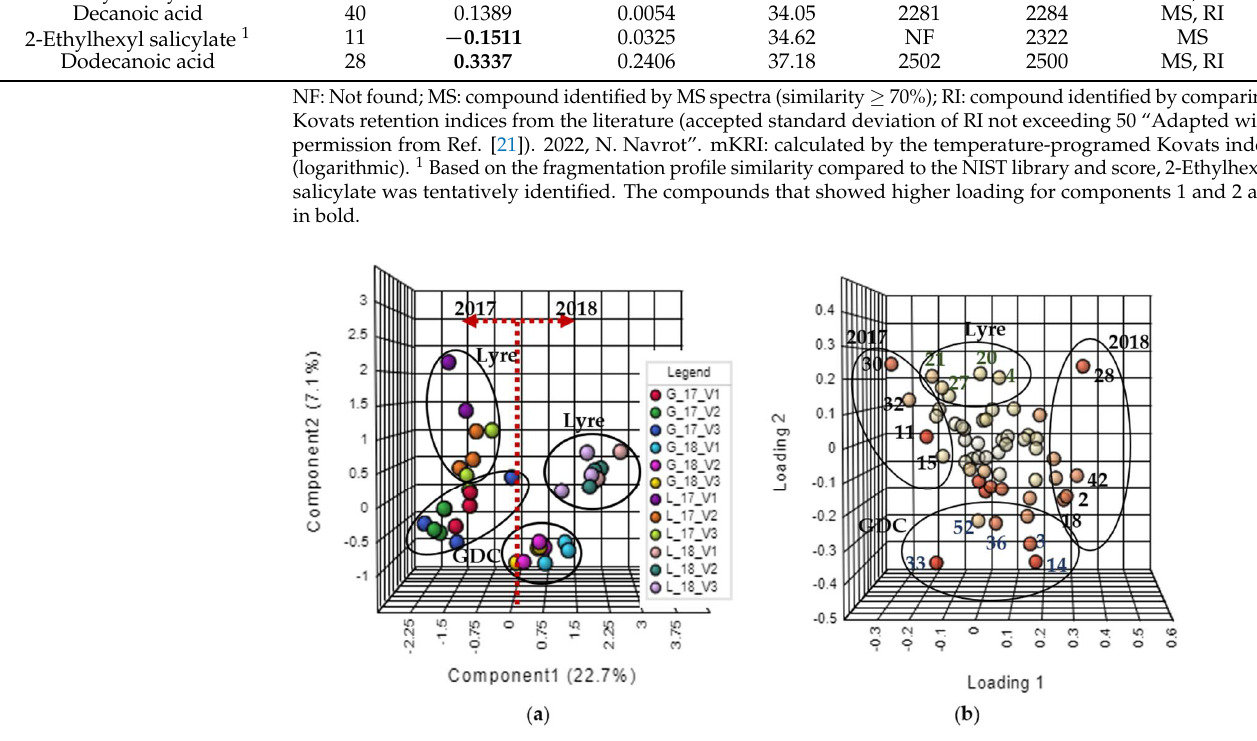
Figure 1. Partial least squares discriminant analysis plots. ( a ) Score plot of the two principal compo- nents of Chardonnay sparkling wines trained on lyre (L) and GDC (G) systems in two seasons (2017 and 2018) and a replicate of vinifications (V). ( b ) Loading plot of the two principal components. Table 1. Compounds identified for both training systems and seasons in a replicate of vinifications of Chardonnay grapes harvested in the southeast of Brazil (Caldas, Minas Gerais), with the follow- ing features: compound identification (ID), loading of each compound for components 1 and 2, re- tention time (RT), modified Kovats retention indeces (mKRI) from the literature and obtained, and the identification approach.